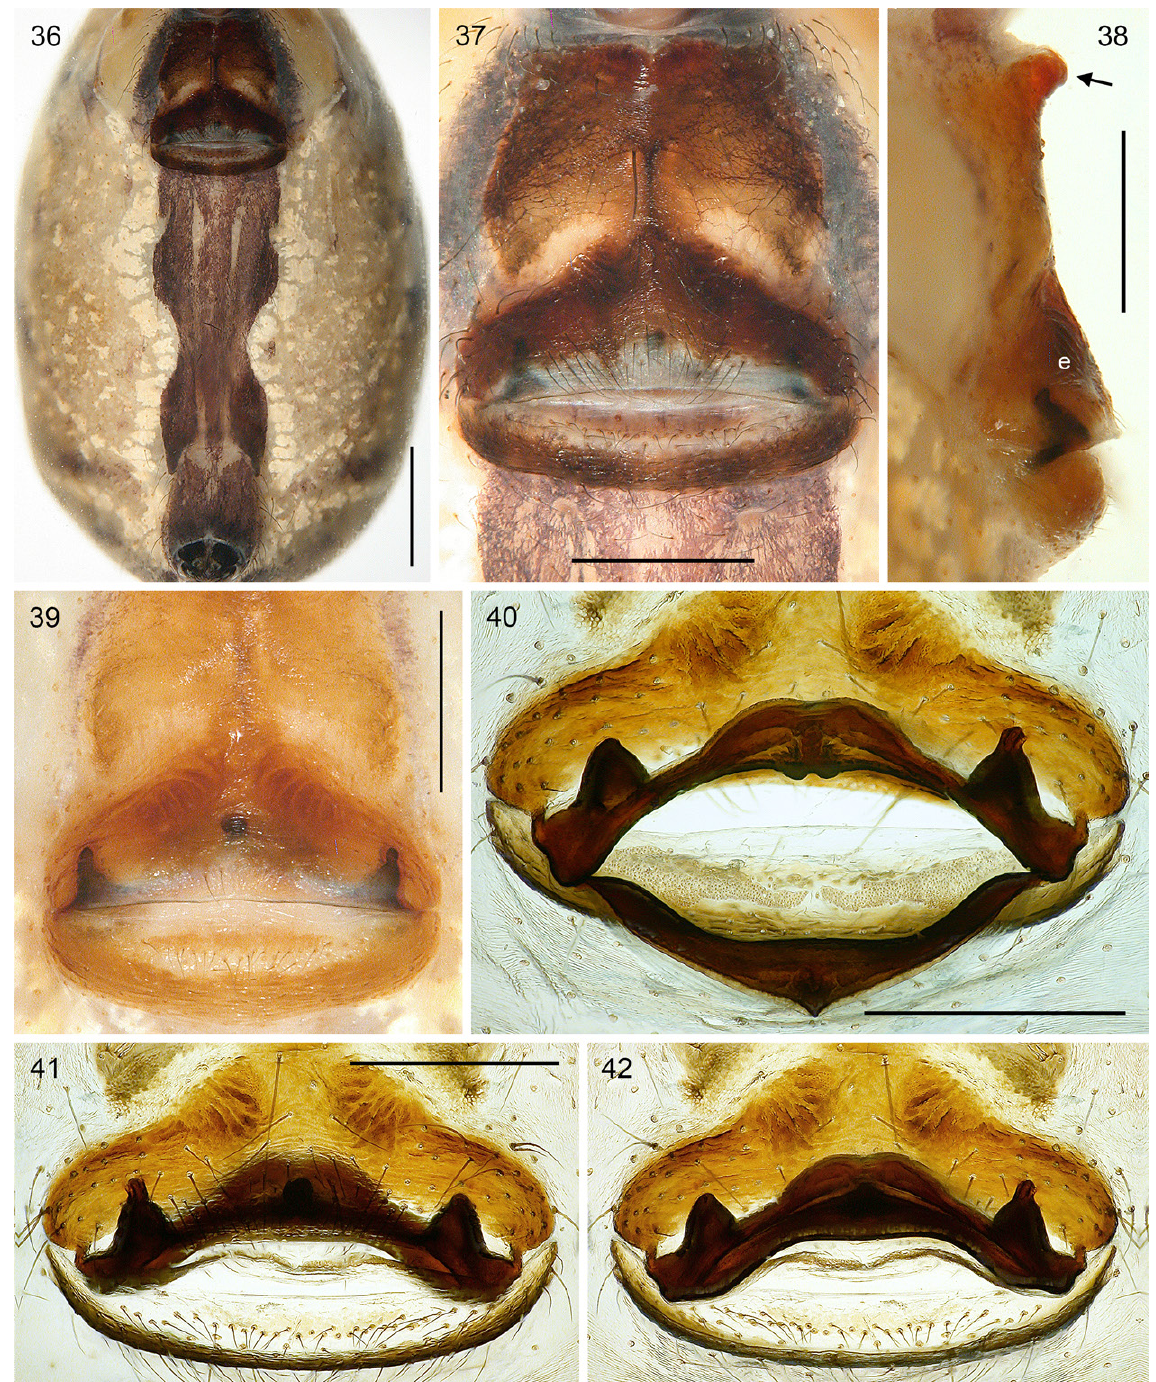
(ZFMK Ar 21373), cleared genitalia, dorsal view with dorsal arc tilted backwards, ventral view, and regular dorsal view. Abbreviation: e = epigynum. Scale bars: 36 = 1.0 mm; 37–42 = 0.5